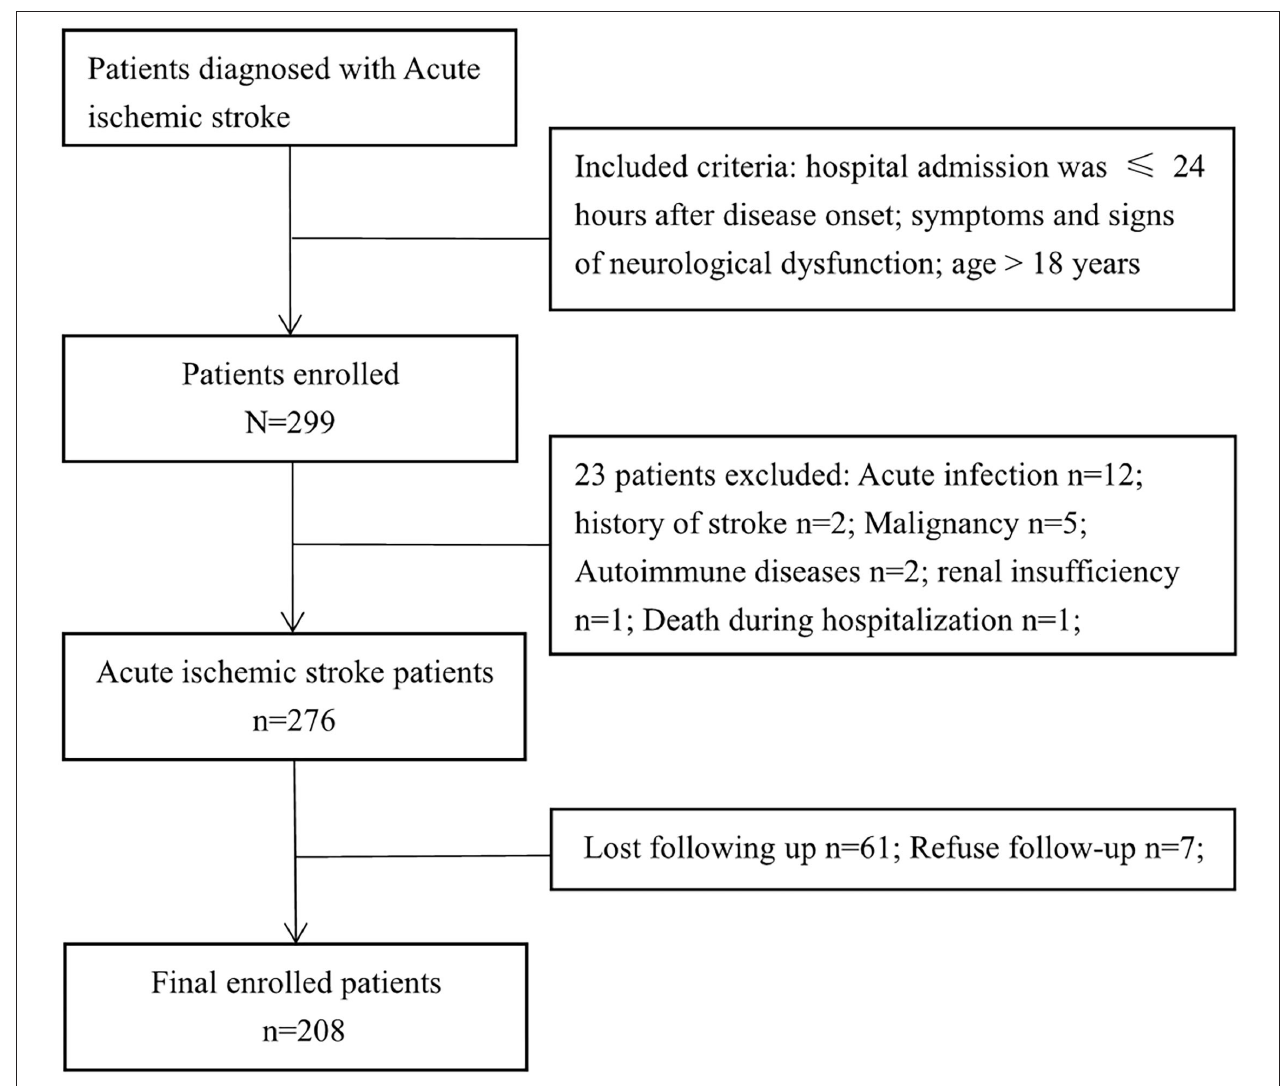
FIGURE 1 | Flow chart for patients’